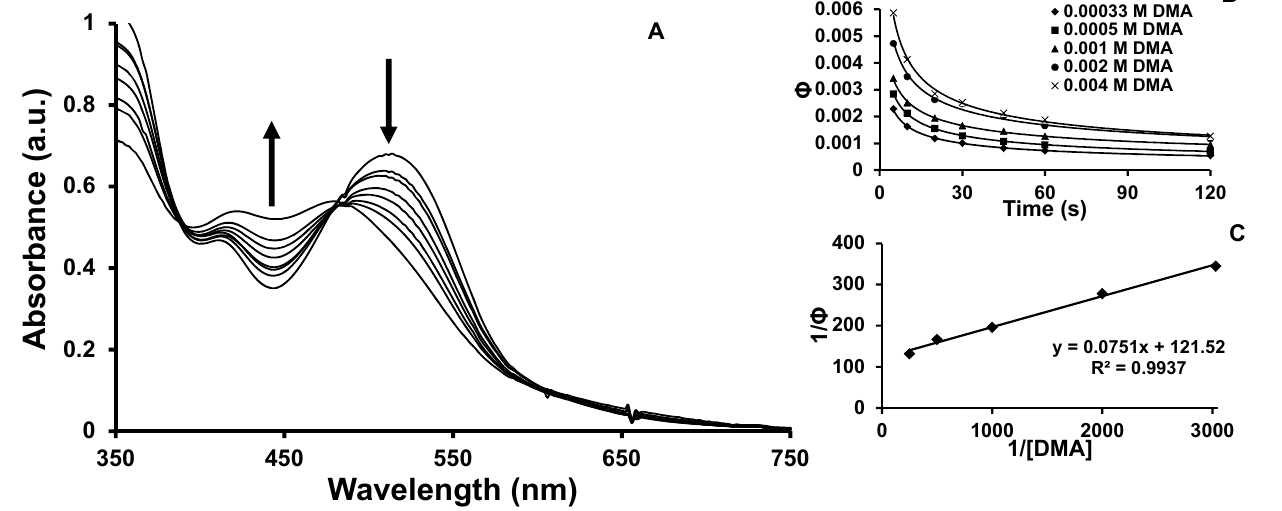
Figure 7. (A) Photochemical reduction of [{(phen) sacrificial electron donor to generate reduced Rh photoproduct; ( B ) Analysis showing non-linear relationship of product formation with respect to photolysis time at varying DMA concentrations; ( C ) Stern-Volmer plot depicting linear relationship between reciprocal of product formation and reciprocal of DMA